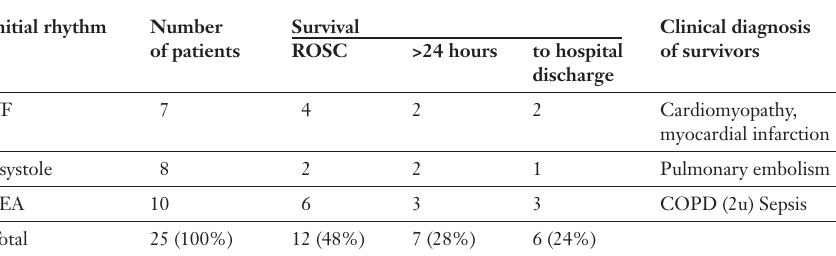
Characteristics of patients. This table shows age and gen- der of patients who underwent resuscita- tion efforts, and the time-period when these efforts were started.